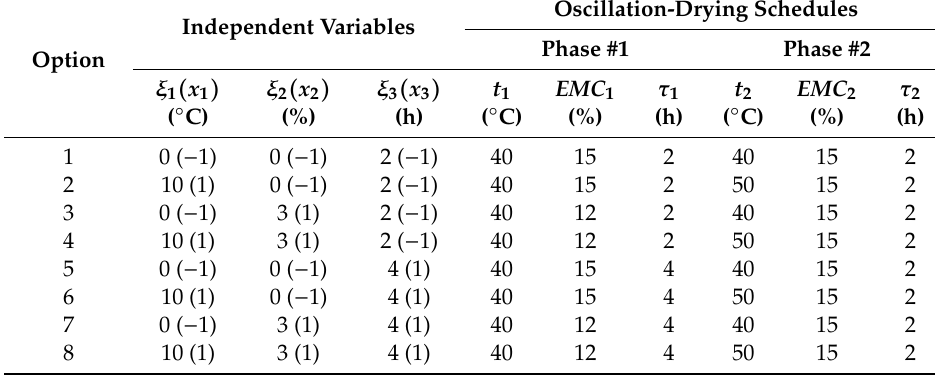
Table 2. Independent and coded variables together with oscillation-drying schedules based on the two-level (2 3 ) factorial design.